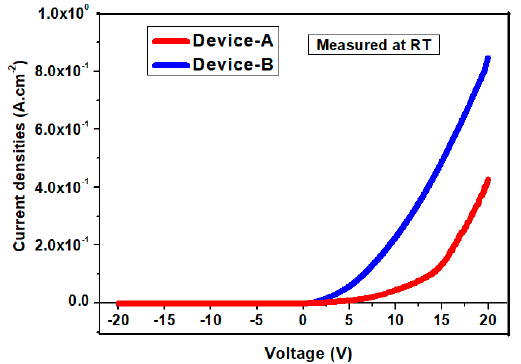
Figure 3. Current – voltage characteristics of p –GaN / n- Si and p –InGaN / n- Si diode, measured at room temperature.